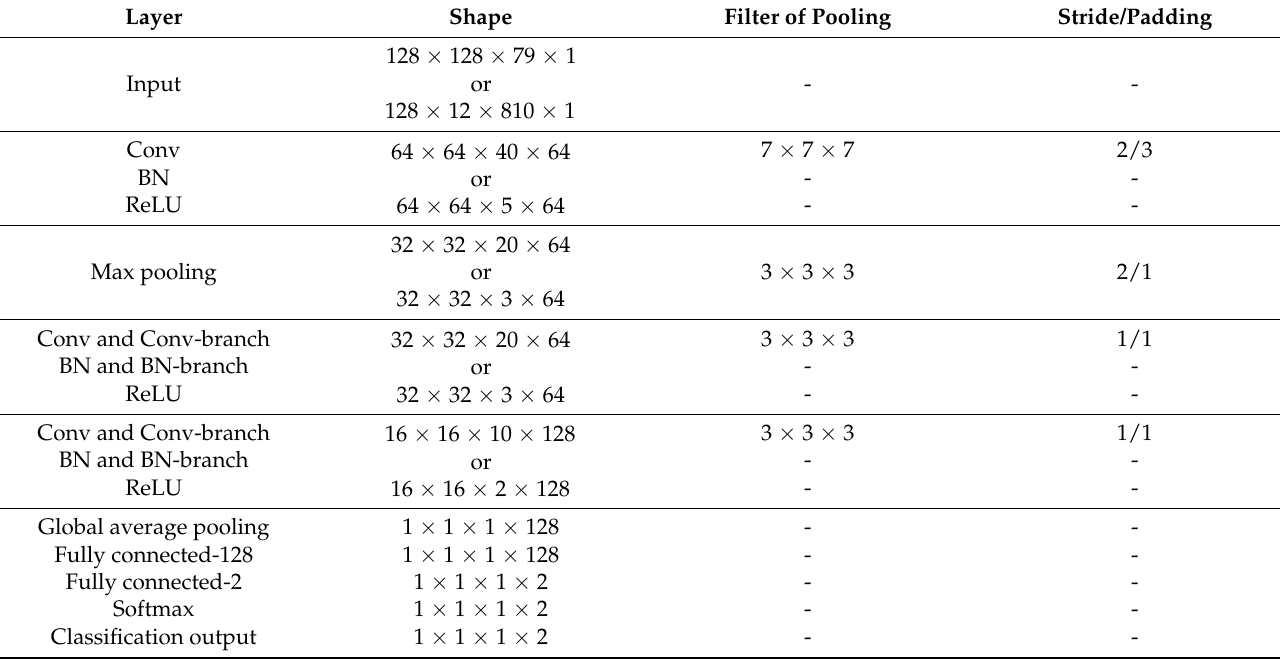
Table 5. Architecture of the